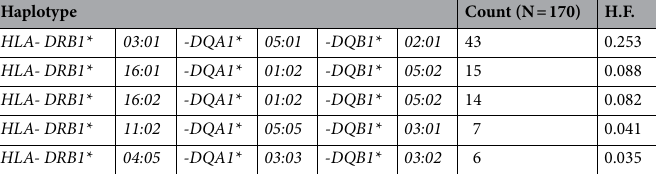
Table 4. Five most frequent HLA-DRB1-DQA1-DQB1 three-locus haplotype counts observed in the UAE cohort. H.F.: haplotypes frequency.